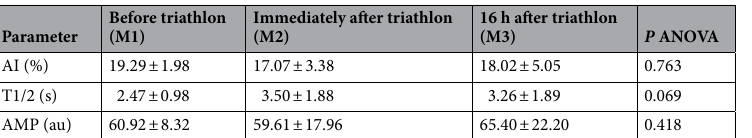
Immediately after triathlon (M2)